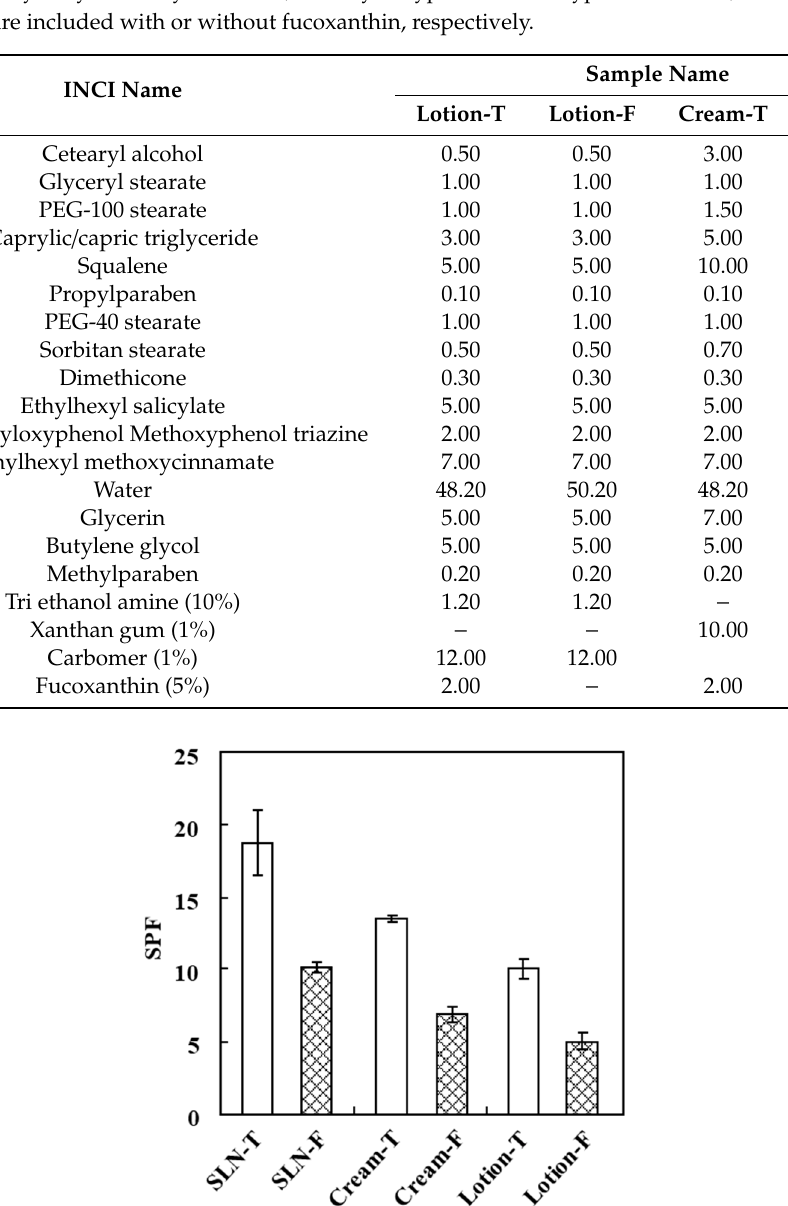
Table 4. Formulation of lotion and cream samples for SPF analysis with SLN samples. Three sunscreen chemicals (ethylhexyl methoxycinnamate, bis-ethylhexyphenol methoxyphenol triazine, and ethylhexyl salicylate) are included with or without fucoxanthin, respectively.